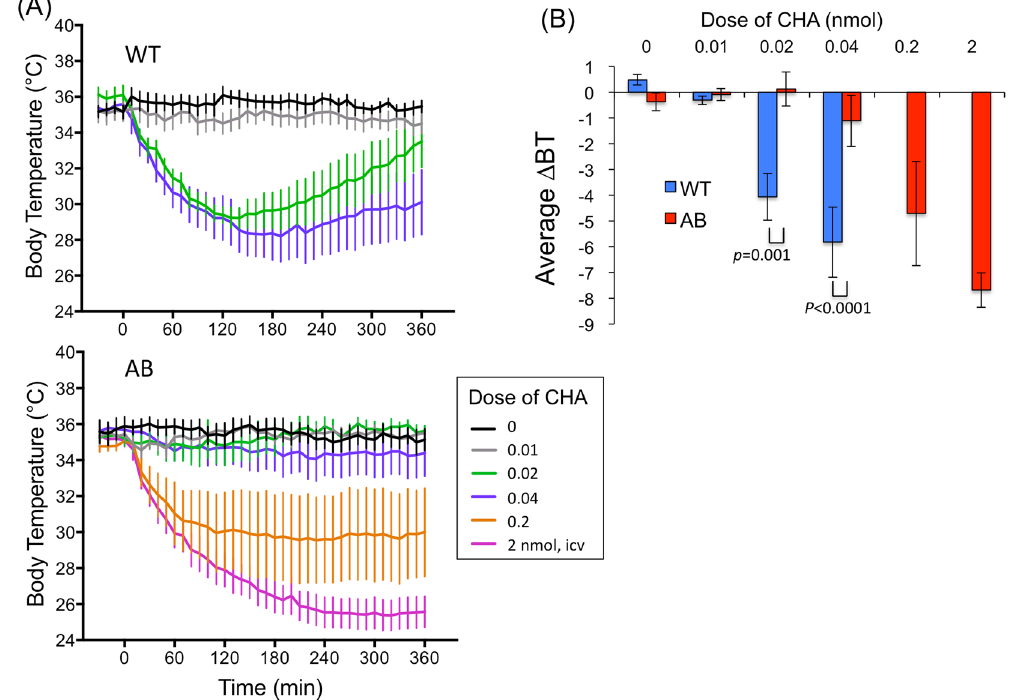
Figure 3. Effect of central administration of an adenosine A1 receptor agonist, N6-cyclohexyladenosine (CHA), on body temperature. ( A ) Time-related changes in body temperature in wild-type mice (WT) and orexin neuron-ablated mice (AB). CHA was intracerebroventricularly injected at time 0. ( B ) Changes in body temperature (BT) averaged for 6 hours following the injection. 2-way ANOVA indicated there were statistical difference between genotypes (F 1,40 = 15.68, p = 0.0003) and doses (F 3,40 = 10.00, p < 0.0001). P values were calculated using the Holm-Sidak multiple comparison test. Each point represents mean ± SEM from 6 animals.